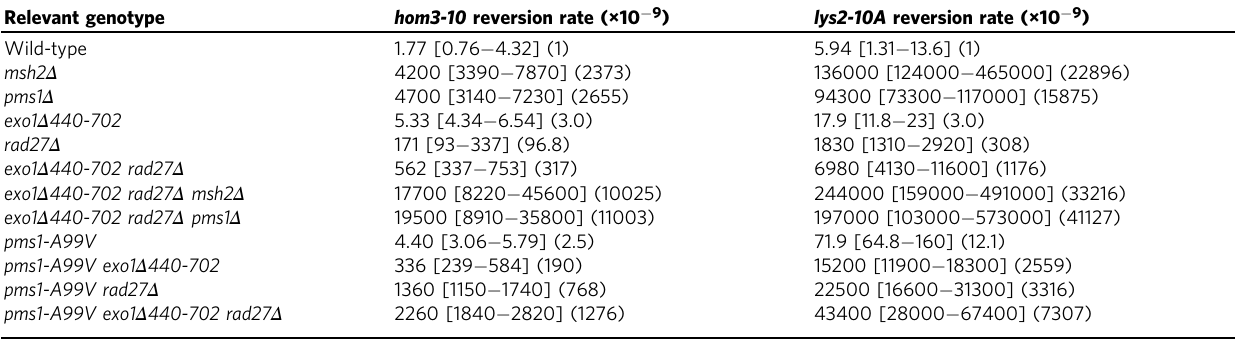
Table 1 MMR defects caused by genetic interactions between exo1 Δ 440-702 , rad27 Δ , and pms1-A99V